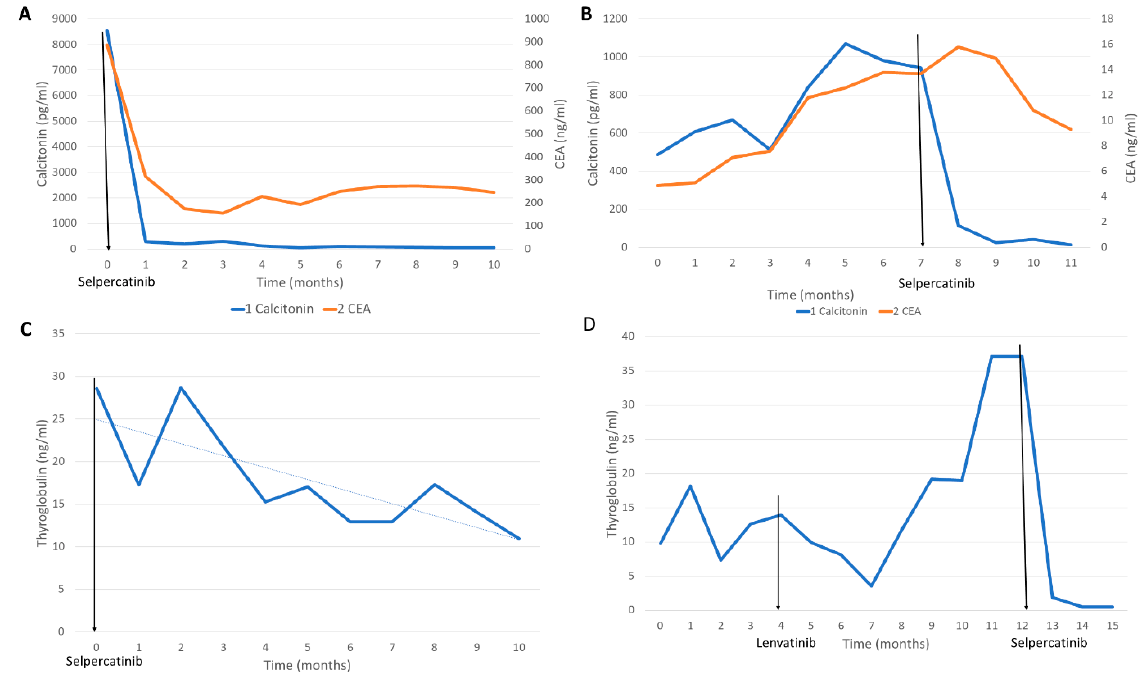
Figure 2. The changes of tumor markers during the selpercatinib treatment for each patient: ( A ) the changes of calcitonin and carcinoembryonic antigen (CEA) of the patient in Case 1; the levels were decreased (for calcitonin, from 8541 pg/mL to 52.91 pg/mL and for CEA, from 886 ng/mL to 247 ng/mL); ( B ) the calcitonin and CEA levels of the patient in Case 2 (for calcitonin, from 944.6 ng/mL to 12.19 ng/mL and for CEA, from 13.7 ng/mL to 9.32 ng/mL); ( C ) the thyroglobulin level of the patient in Case 3 (from 28.57 ng/mL to 10.96 ng/mL); ( D ) the thyroglobulin level of the patient in Case 4 (from 37.11 ng/mL to 0.48 ng/mL). Table 1. Summary of cases.